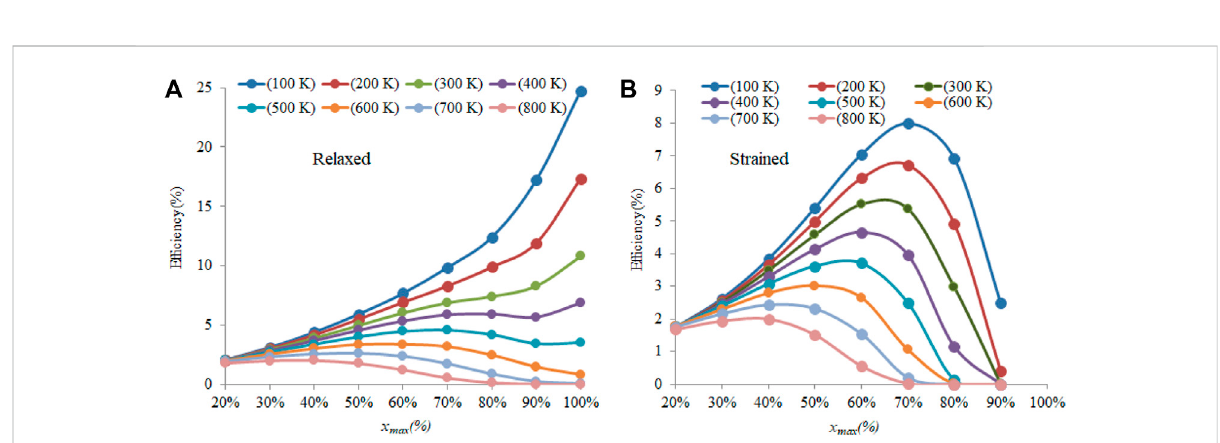
FIGURE 12 Ef fi ciency for both (A) relaxed and (B) strained conditions at different temperatures for different x